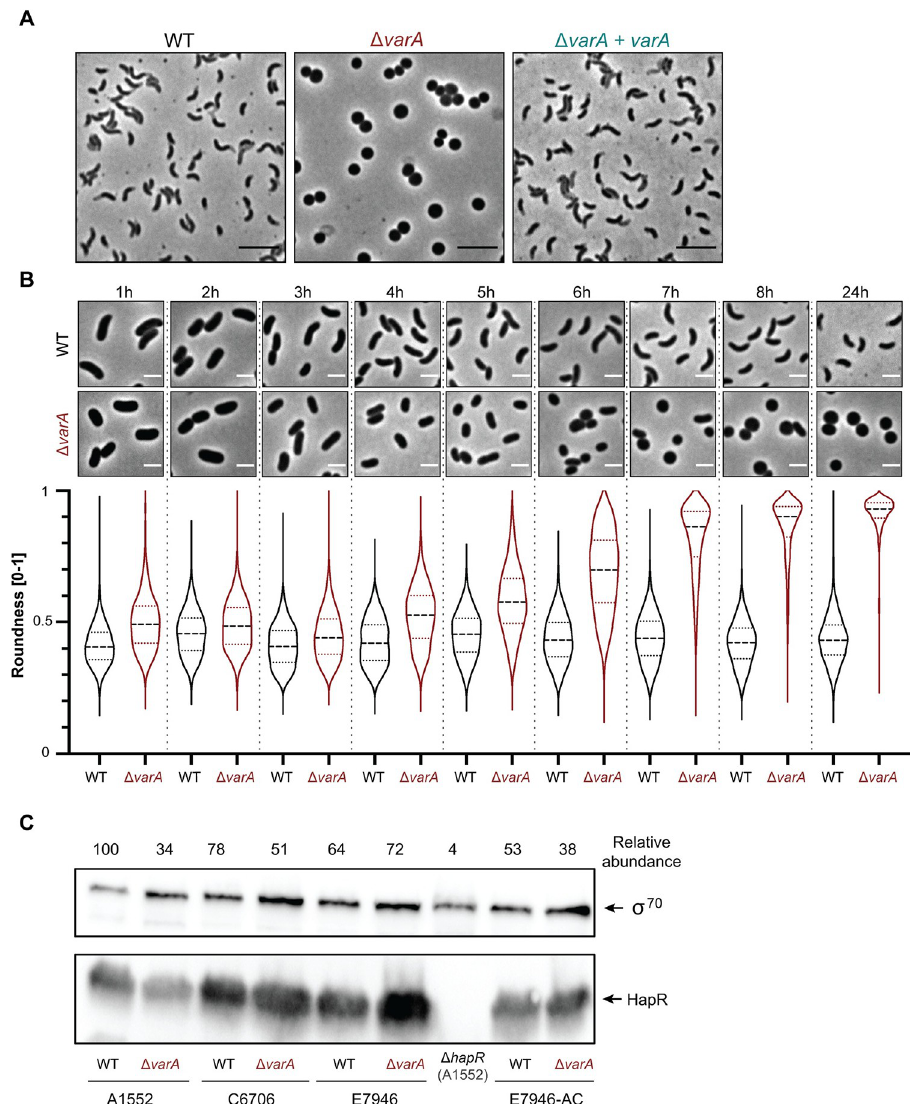
Fig 1. V . cholerae Δ varA cells change their morphology at later stages of growth. (A) Δ varA cells grown overnight are round. Phase contrast micrographs of the WT, Δ varA , and the complemented Δ varA + varA strains that were grown for 20 h. Scale bar: 5 μ m. (B) Δ varA cells become round during late growth. Phase contrast microscopy imaging (top) and quantification (roundness values at the bottom) of the WT and Δ varA strains during growth. Cells were imaged every hour for 8 h and again at 24 h post-dilution. Scale bar: 2 μ m. The roundness was quantified using the MicrobeJ software and is based on 3,000 cells each (n = 1000 per biologically independent experiment). (C) Δ varA cells produce the QS regulatory protein HapR. Western blot analysis to detect the HapR protein levels in the different V . cholerae El Tor pandemic strains A1552, C6707, E7946, and their varA- deficient mutants, with the A1552 Δ hapR strain as a negative control (strain details are provided in S4 Table). All strains were sampled at an OD 600 of ~2.5. Representative blot from three independent experiments. Detection of σ 70 served as a loading control. The densitometric quantification of the HapR abundance is shown above the blots (normalized to the σ 70 signal and to the WT (A1552), which was set to 100).